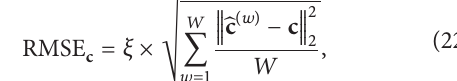
Figure 3: The average number of iterations needed for convergence against